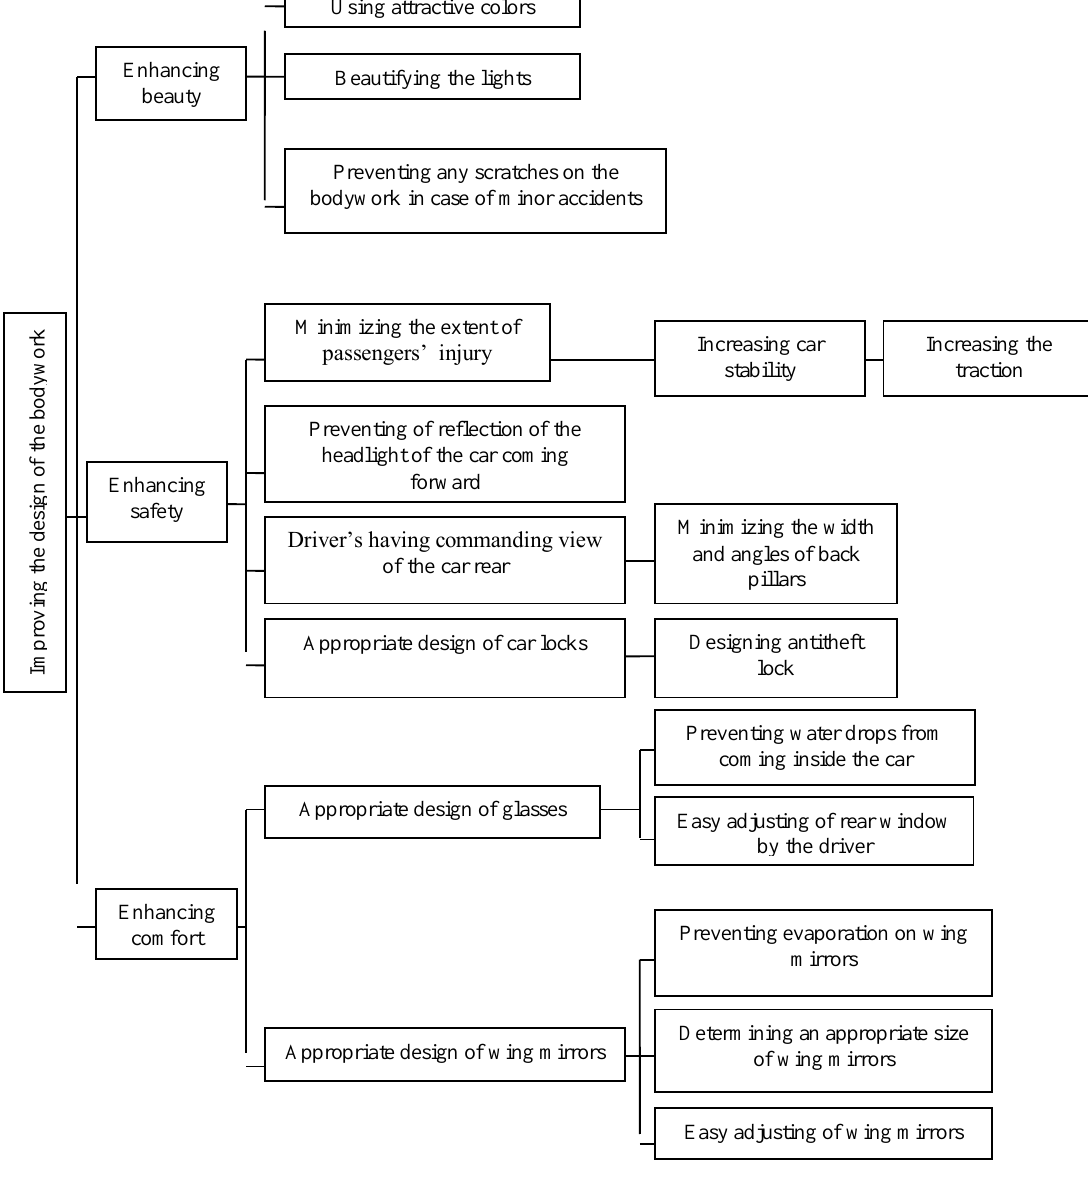
Figure 2. Fast diagram for the pride